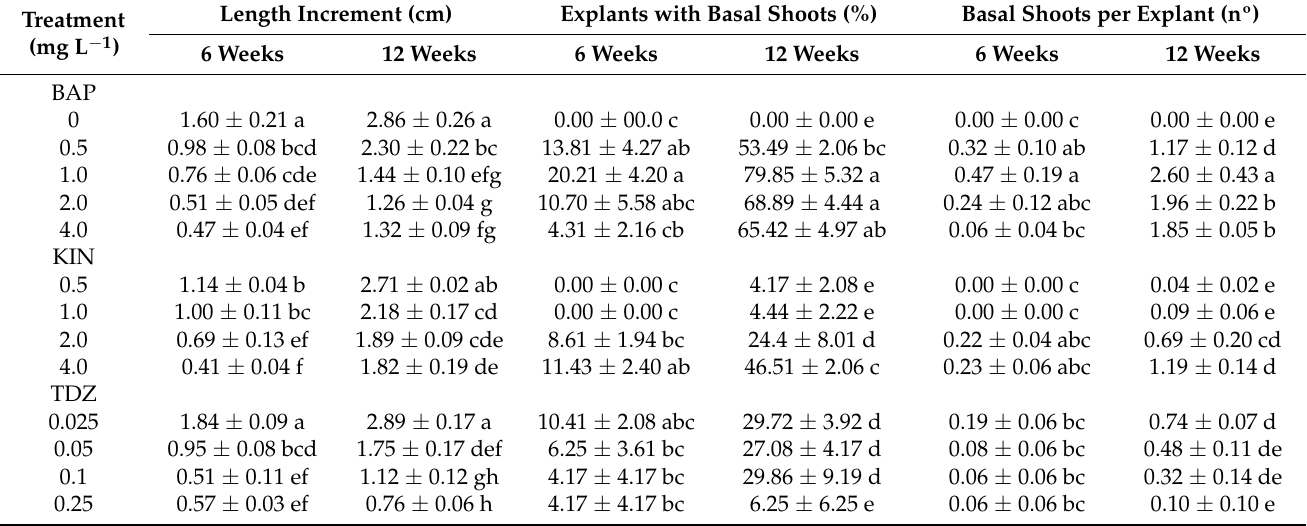
Table 1. Effect of 13 concentrations of 6-benzylaminopurine (BAP), kinetin (KIN), and thidiazuron (TDZ) on Tetraclinis articulata (Vahl) Masters multiplication after 6 weeks of in vitro cultivation (mean ± SE) on SH medium (Schenk and Hildebrandt, 1972) and further culture in SH medium without PGRs for 6 more weeks. Mean values within a column, followed by the same letter are not significantly different by Duncan’s multiple range test at the 95% level of